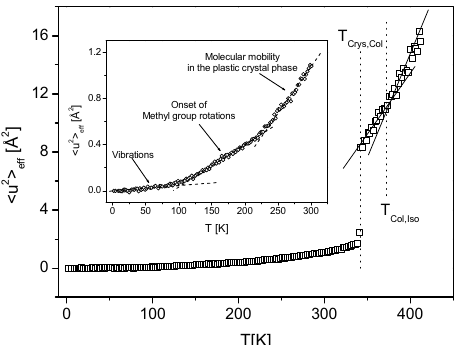
Figure 3. VDOS at T = 80K in the frequency range of the Boson Peak for HAT5 (open squares) and HAT6 (filled circles). The lines are guides for the eyes.